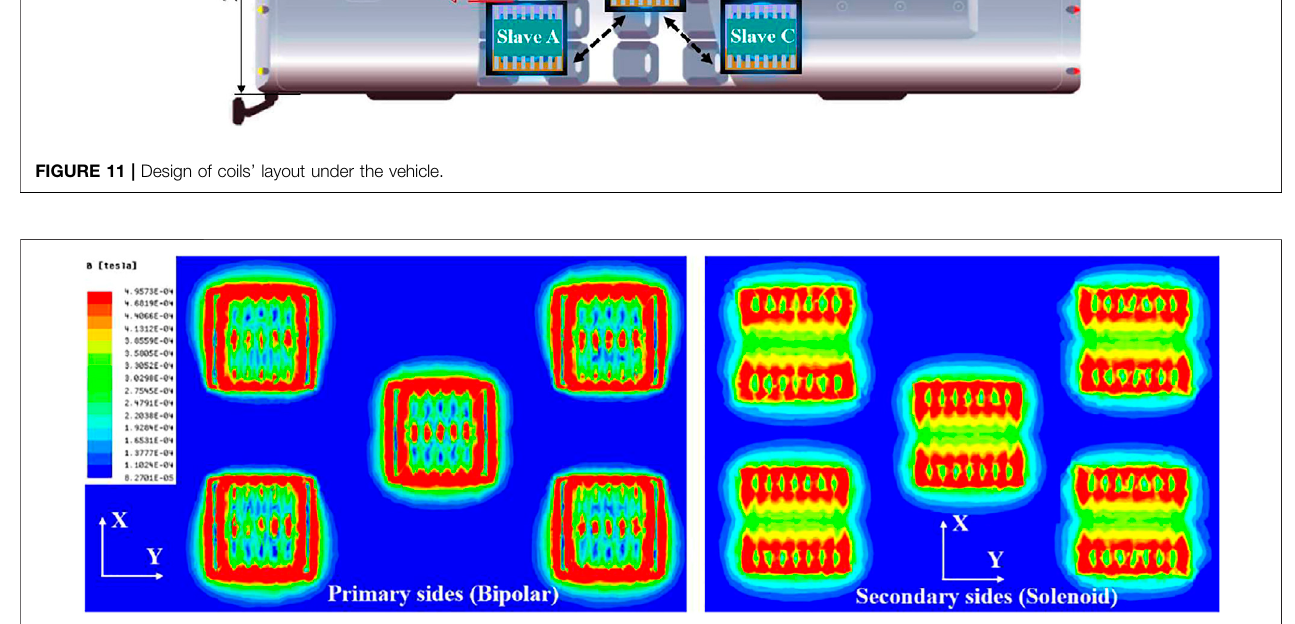
FIGURE 12 | Magnetic fi eld distribution of the modular WPT system (X-Y